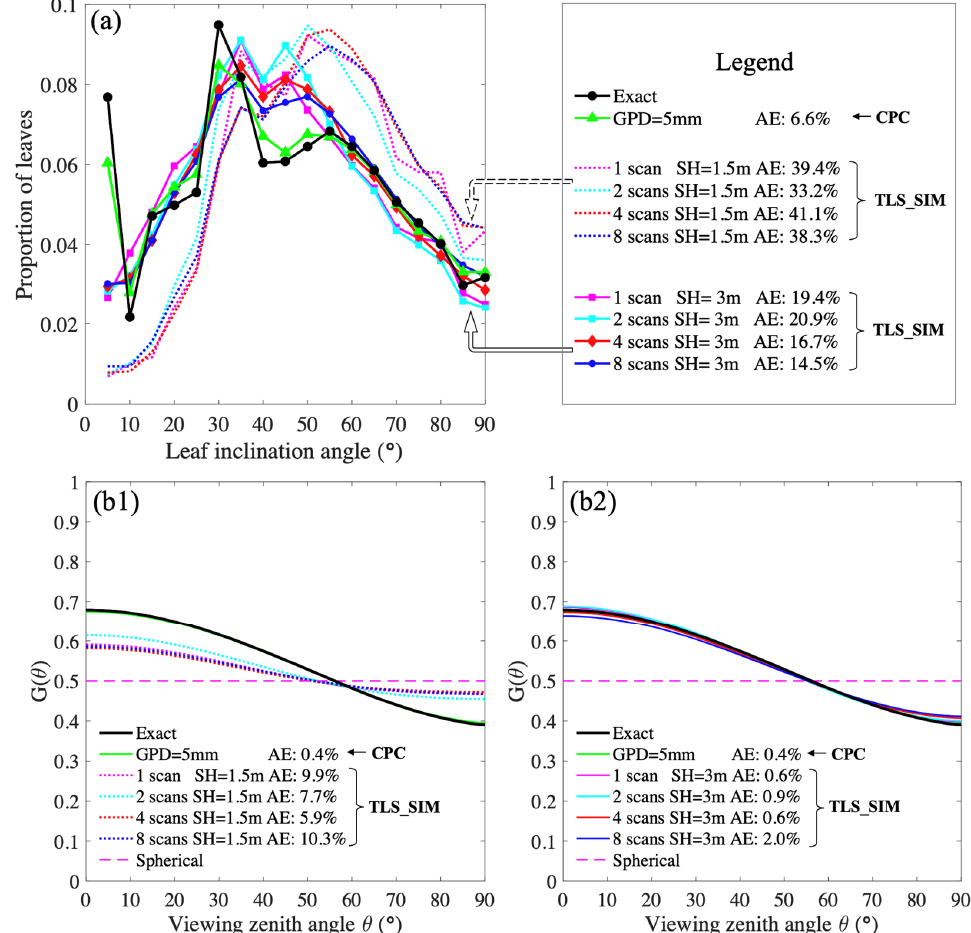
Figure 5. The effect of the number of scans and the scanner height on the leaf angle distribution (LAD) ( a ) and the G-function ( b1 , b2 ) for Tree1; ( b1 , b2 ) are the results for scanner heights (SHs) of 1.5 m and 3 m, respectively: the “Exact” curves in black are the true LADs and G-functions computed from the three-dimensional (3D) tree model; the green curves are the LAD and the G-function computed from the complete point clouds (CPC) with a grid point distance (GPD) of 5 mm, which can represent the accuracy without the occlusion effect; TLS_SIM denotes simulated TLS point clouds. The scanning strategy is illustrated in Figure 1(d1).